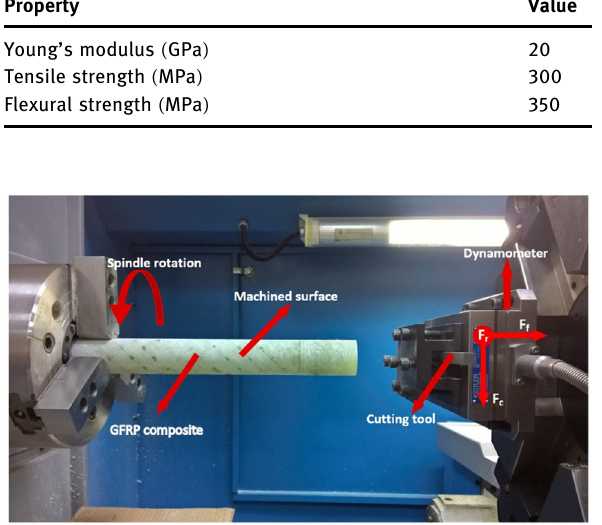
Figure 1: Experimental setup.